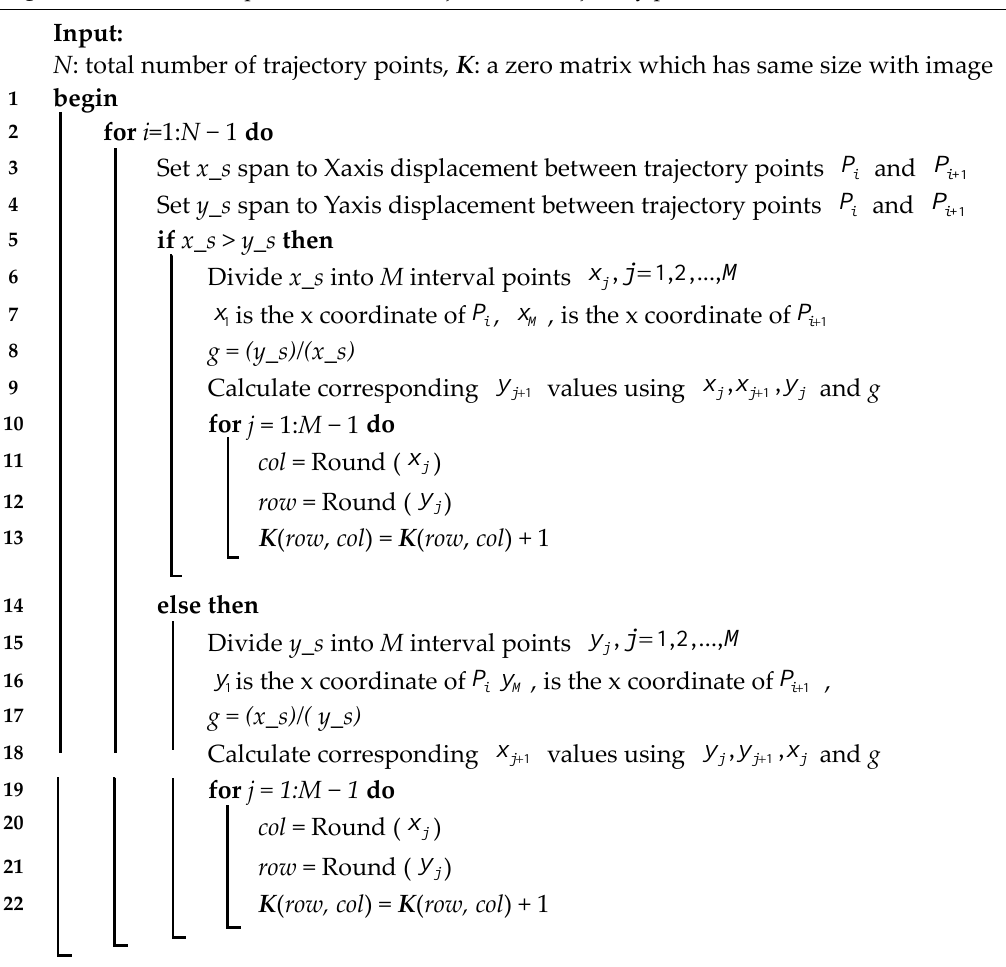
Sensors 2018 , 18 , x 8 of 27